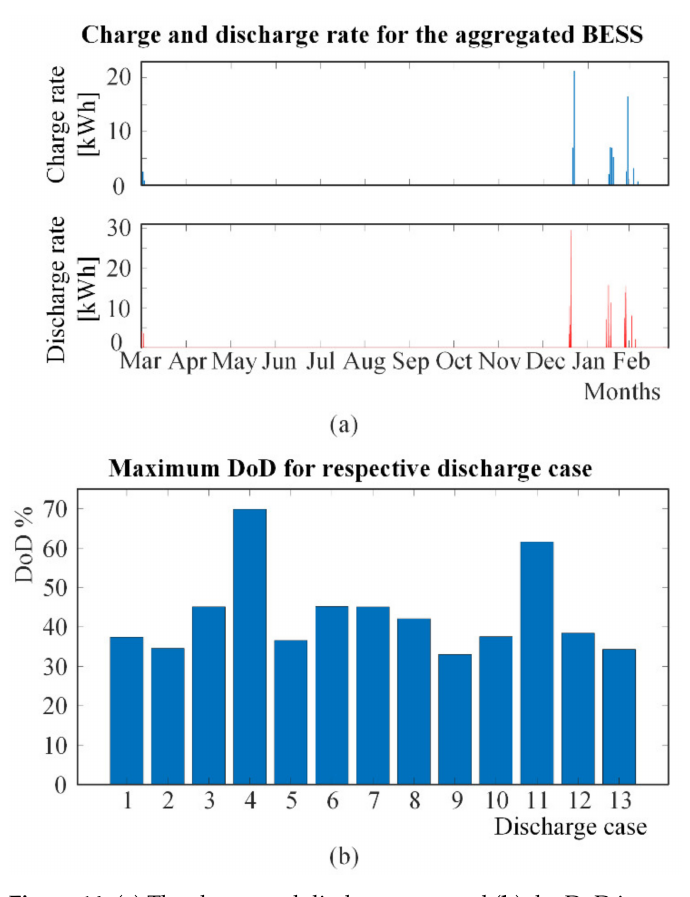
Figure 14. ( a ) The charge and discharge rate and ( b ) the DoD in case of aggregated